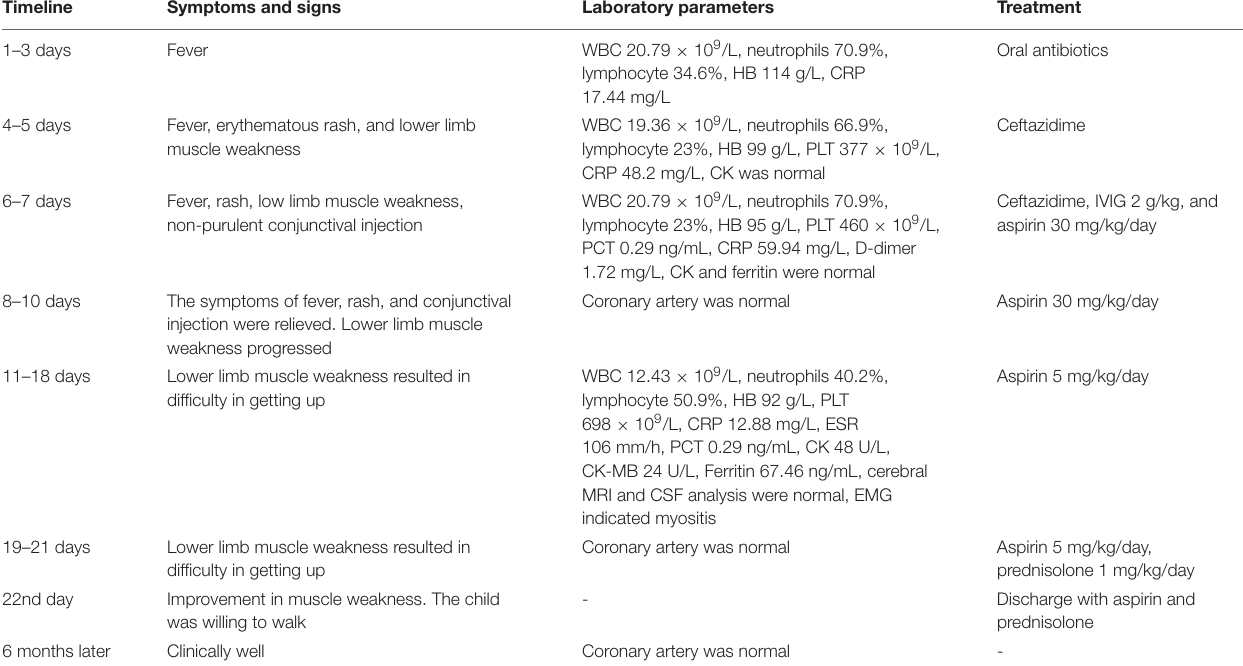
TABLE 1 | The timeline of